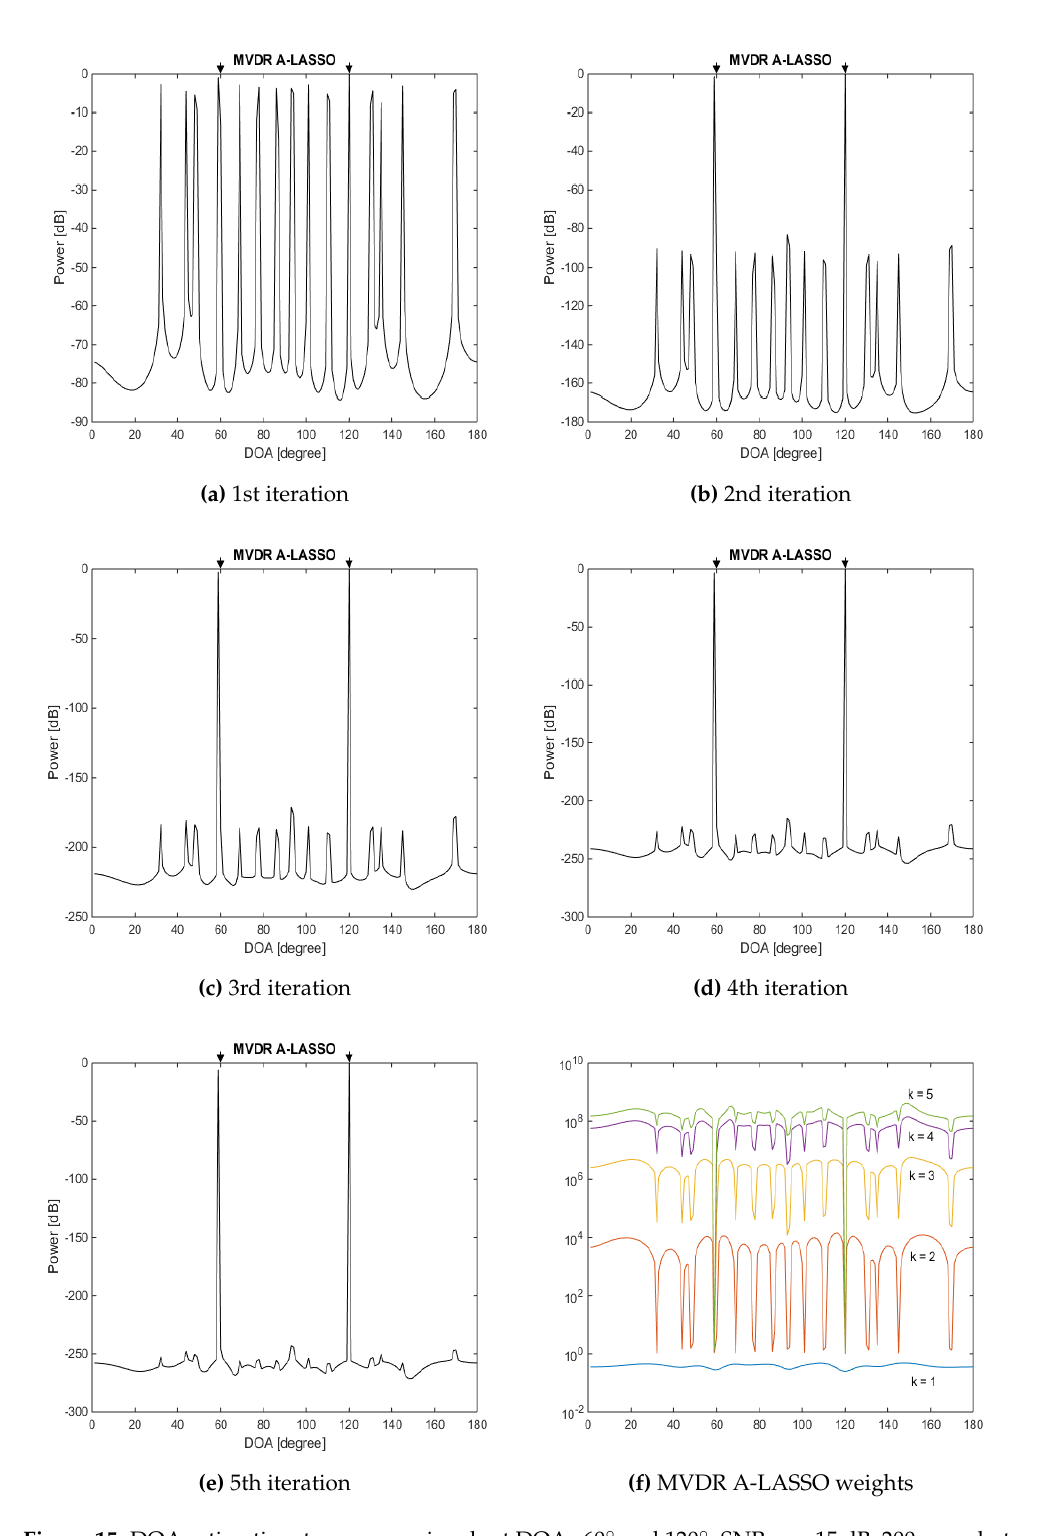
Figure 15. DOA estimation, two source signals at DOAs 60 ◦ and 120 ◦ , SNR = − 15 dB, 200 snapshots, using the MVDR A-LASSO algorithm. ( a ) to ( e ) after one to five iterations; and ( f ) MVDR A-LASSO weights as the number of iterations k